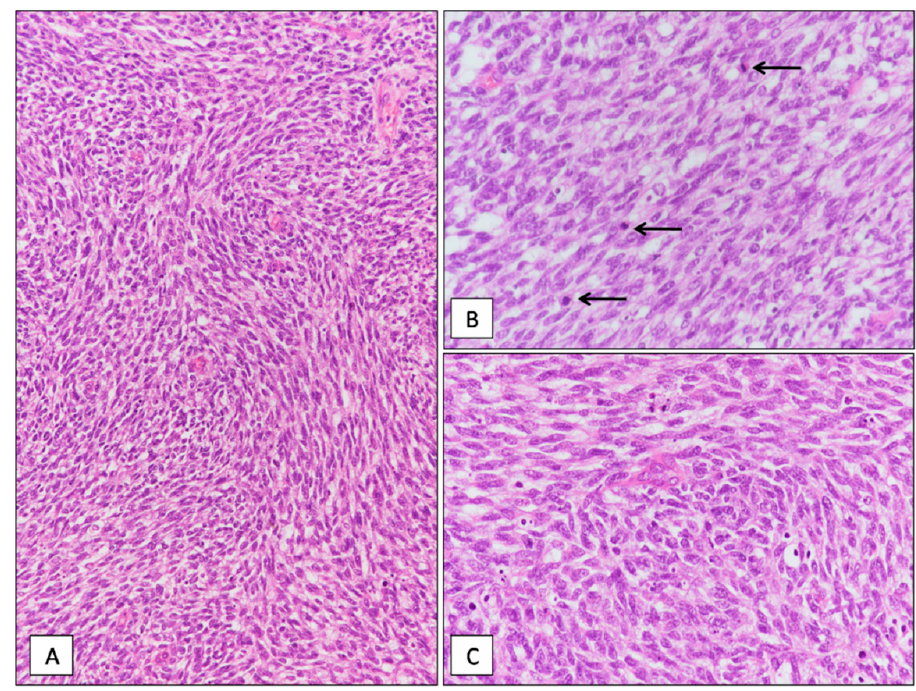
Figure 2. Histological examination. ( A ) The tumor was composed of closely packed spindle cells with scant cytoplasm and oval nuclei, arranged into short intersecting fascicles with scant interposed stroma (hematoxylin and eosin; original magnification 150×). ( B ) Higher magnification showing moderate nuclear atypia and three mitoses (arrows) (hematoxylin and eosin; original magnification 400×). ( C ) Numerous neoplastic apoptotic cells are seen (hematoxylin and eosin; original magnification 400×).